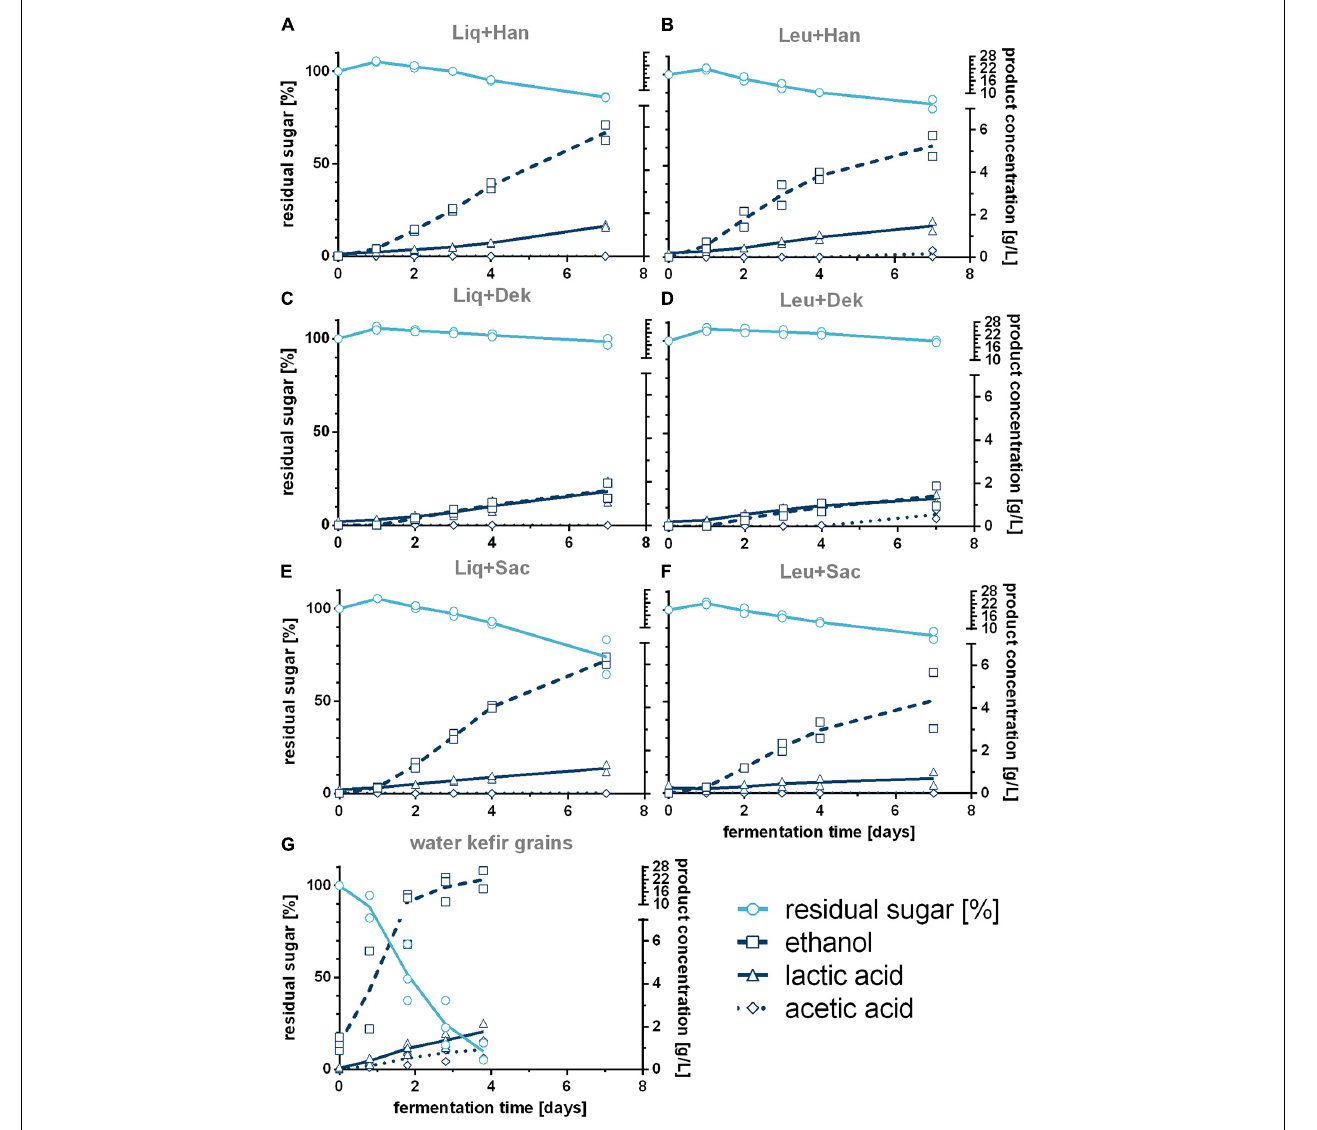
FIGURE 2 | Course of produced ethanol, lactic, and acetic acid and consumed sugar during the WK fermentations with different LAB–yeast combinations (A–F) and complex grains (G) . Shown are the data of biological duplicates (LAB–yeast combinations) or biological triplicates (complex grains) and the corresponding trend lines. WK, water kefir; LAB, lactic acid